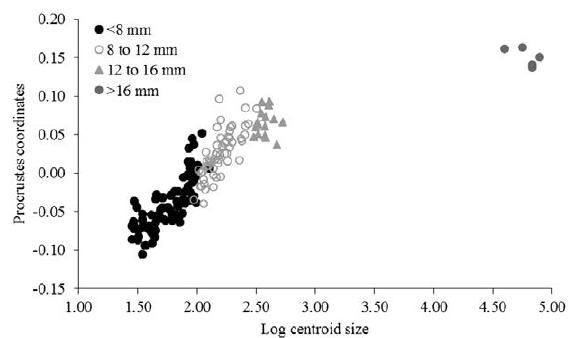
Fig. 4. – Regression between Procrustes coordinates and logarithm of centroid size: morphometric change occurrence and allometry during the early ontogenetic development of S. sanguineus